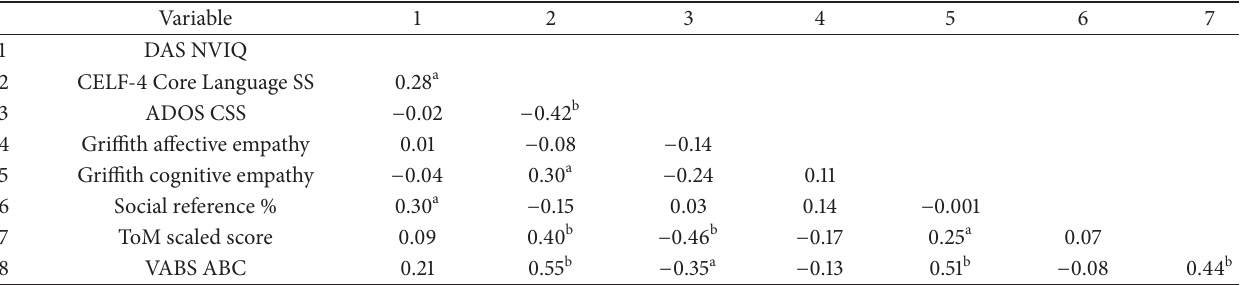
Table 3: Behavioral intercorrelations.